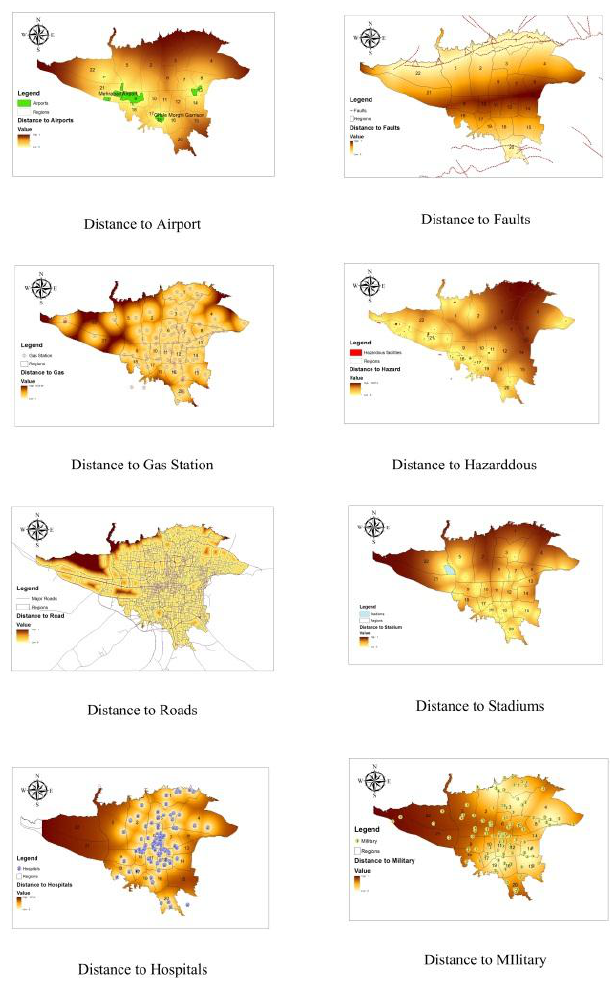
Figure 3. Input map layers used in this